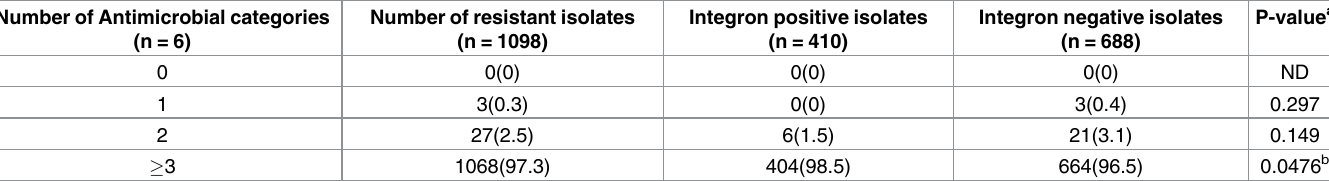
Table 2. Frequency of multidrug resistance among faecal Escherichia coli isolates. Number of Antimicrobial categories (n =